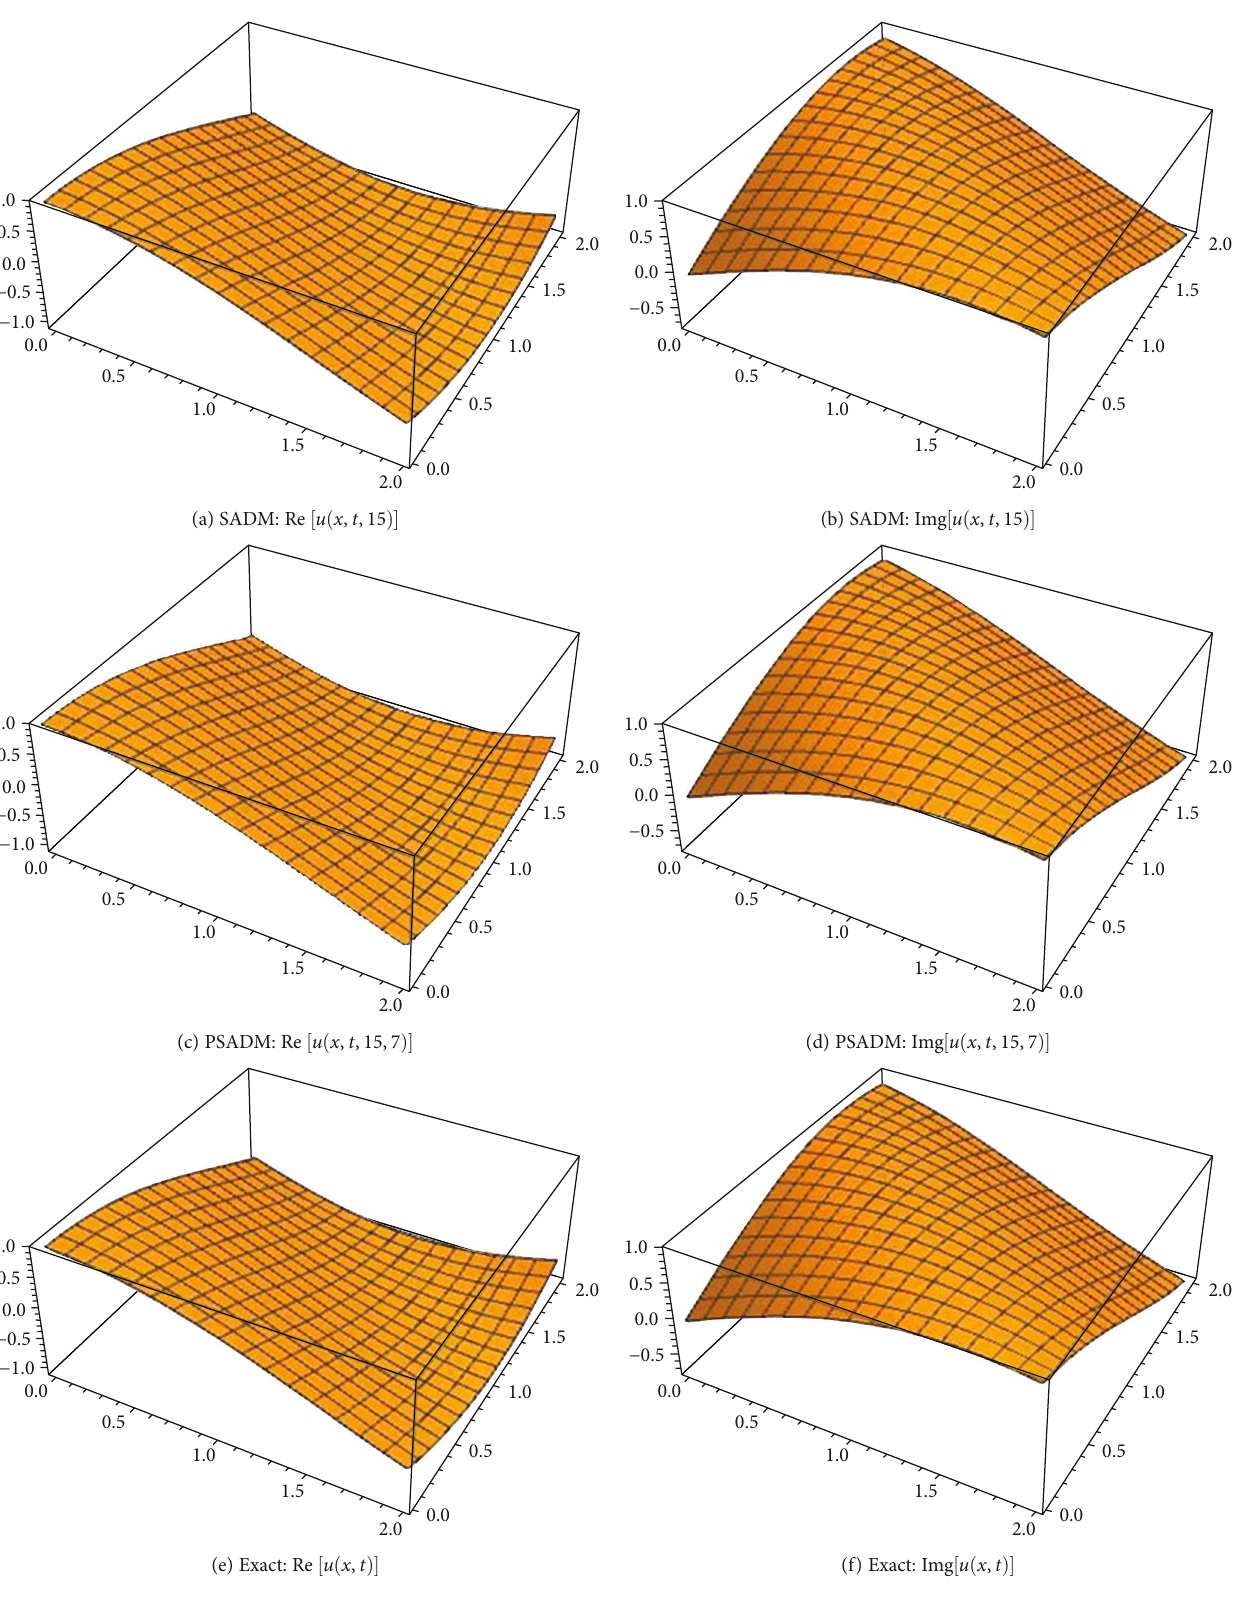
Figure 1: (a – d) SADM and PSADM solutions using 15 terms. (e, f) Exact